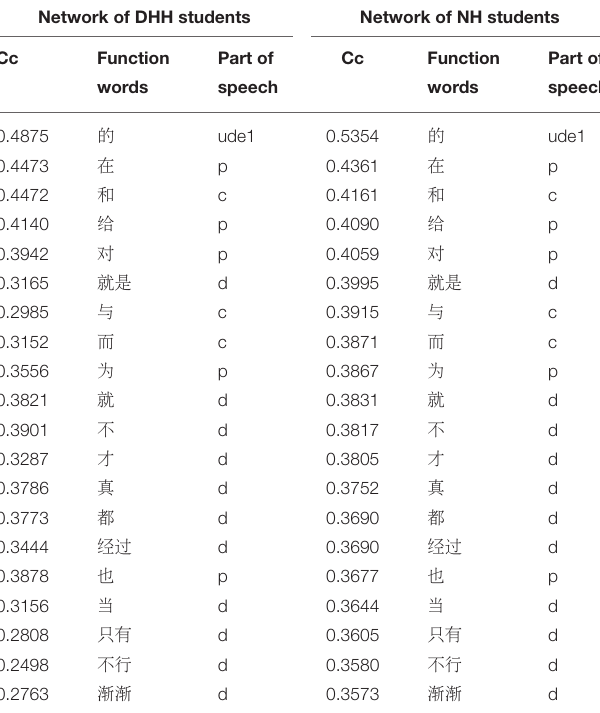
TABLE 5 | Betweenness centrality (Bc) of 20 function words in the two networks. Network of DHH students